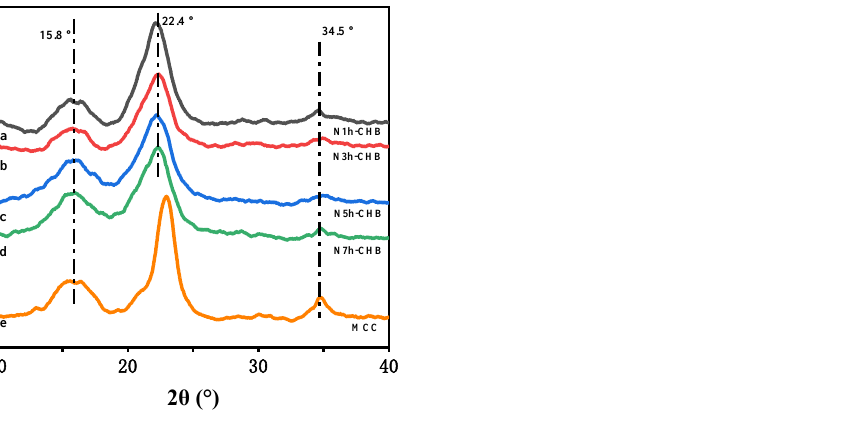
Figure 7. XRD spectra: (a) N1h-CHB cellulose; (b) N3h-CHB cellulose; (c) N5h-CHB cellulose; (d) N7h-CHB cellulose; (e) MCC.